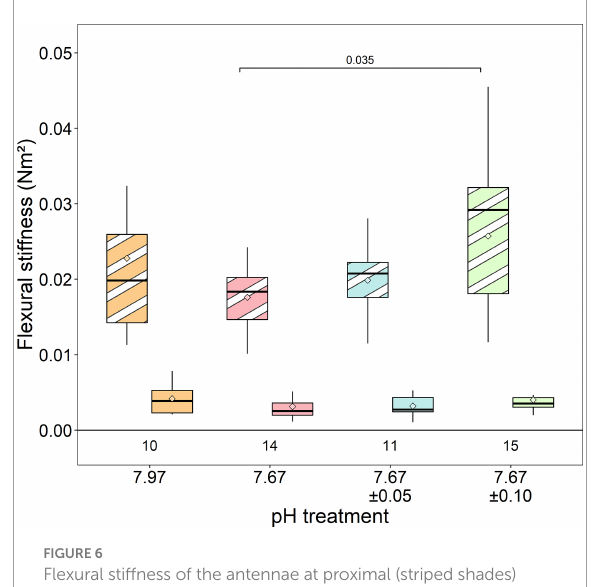
FIGURE 6 Flexural stiffness of the antennae at proximal (striped shades) and distal (solid shades) locations. The low stiffness at the distal location was similar across all treatments. While antennae from the reduced/high fluctuating treatment were stiffer at the proximal base than lobsters in the reduced/stable pH treatment, there were no significant differences in flexural stiffness from the ambient/stable treatment. Box boundaries are the first and third quartiles, whiskers are 1.5 times the interquartile range, the center line is the median, and black and white diamonds are the mean. Values on the bottom of panels denote sample